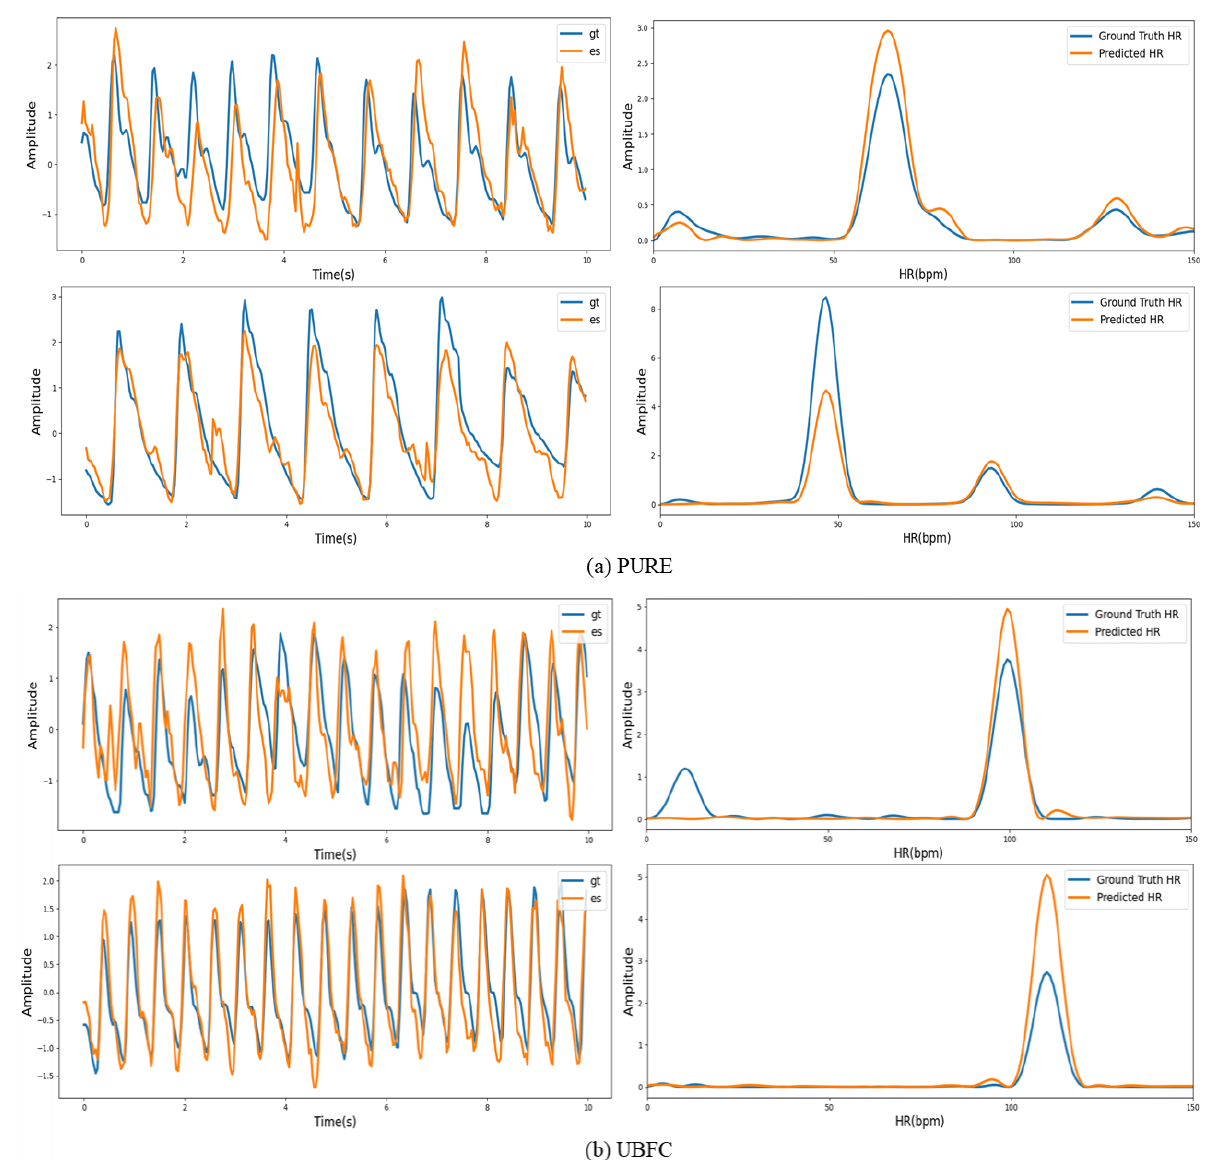
Figure 10. ( a ) Visualization of the predicted rPPG signals in the PURE dataset. ( b ) Visualization of the predicted rPPG signals in the UBFC